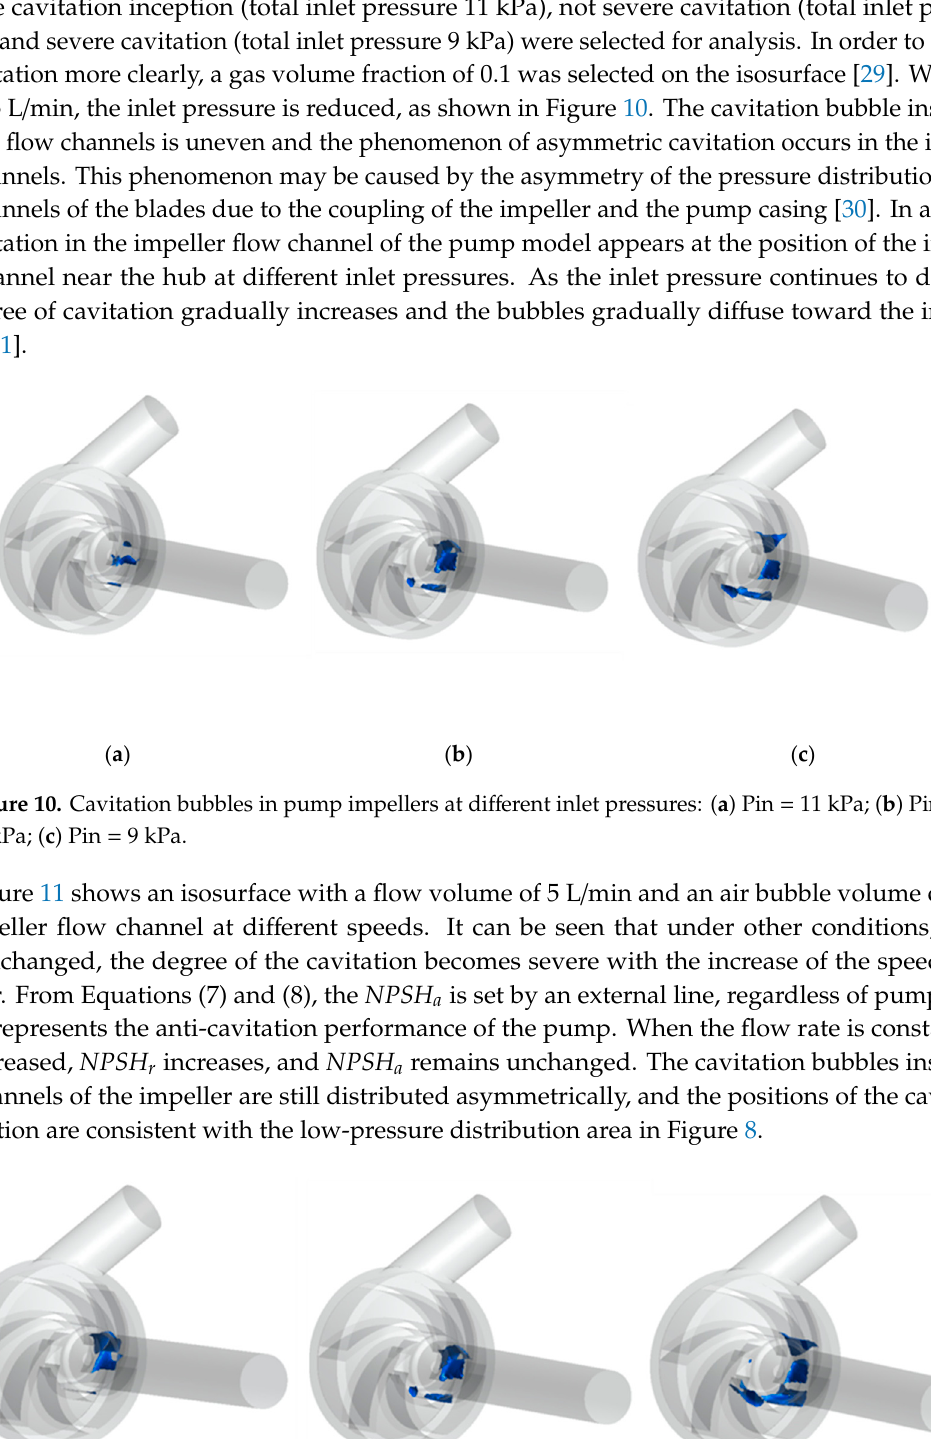
Figure 9. Cavitation characteristics of the centrifugal blood pump.